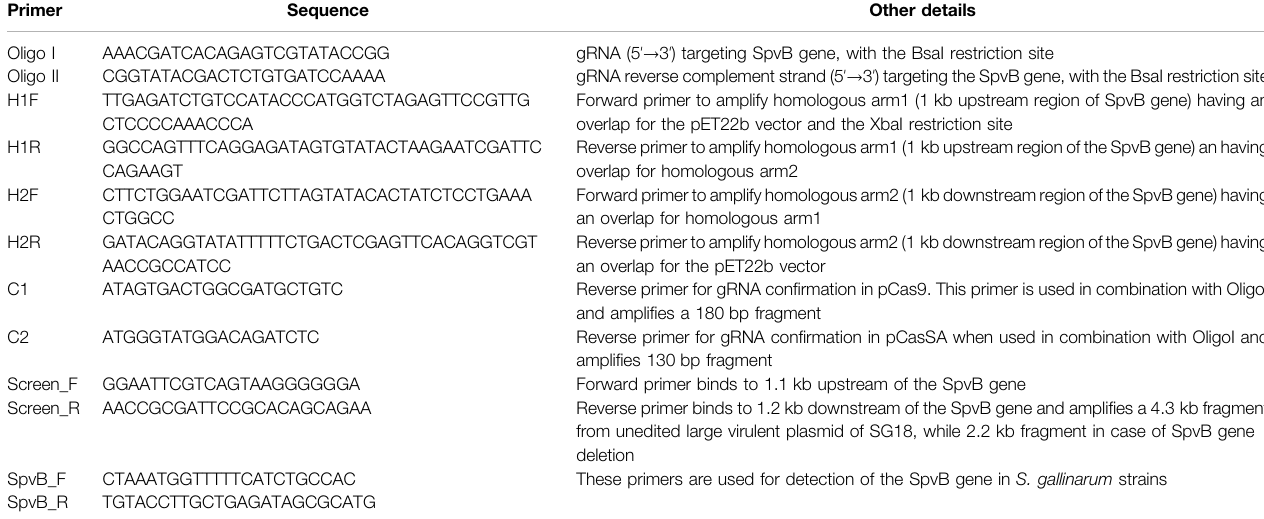
TABLE 1 | Details of the primers used in this